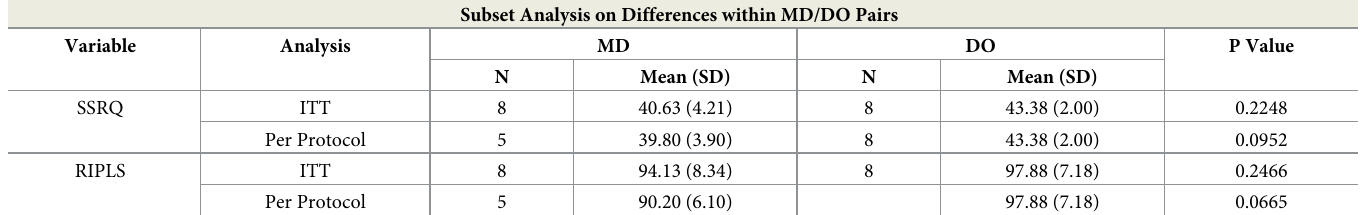
Table 3. Subset analysis using non-parametric Wilcoxon rank-sum test assessing the difference in SSRQ and RIPLS between MD and DO patients within the MD/ DO pairs.